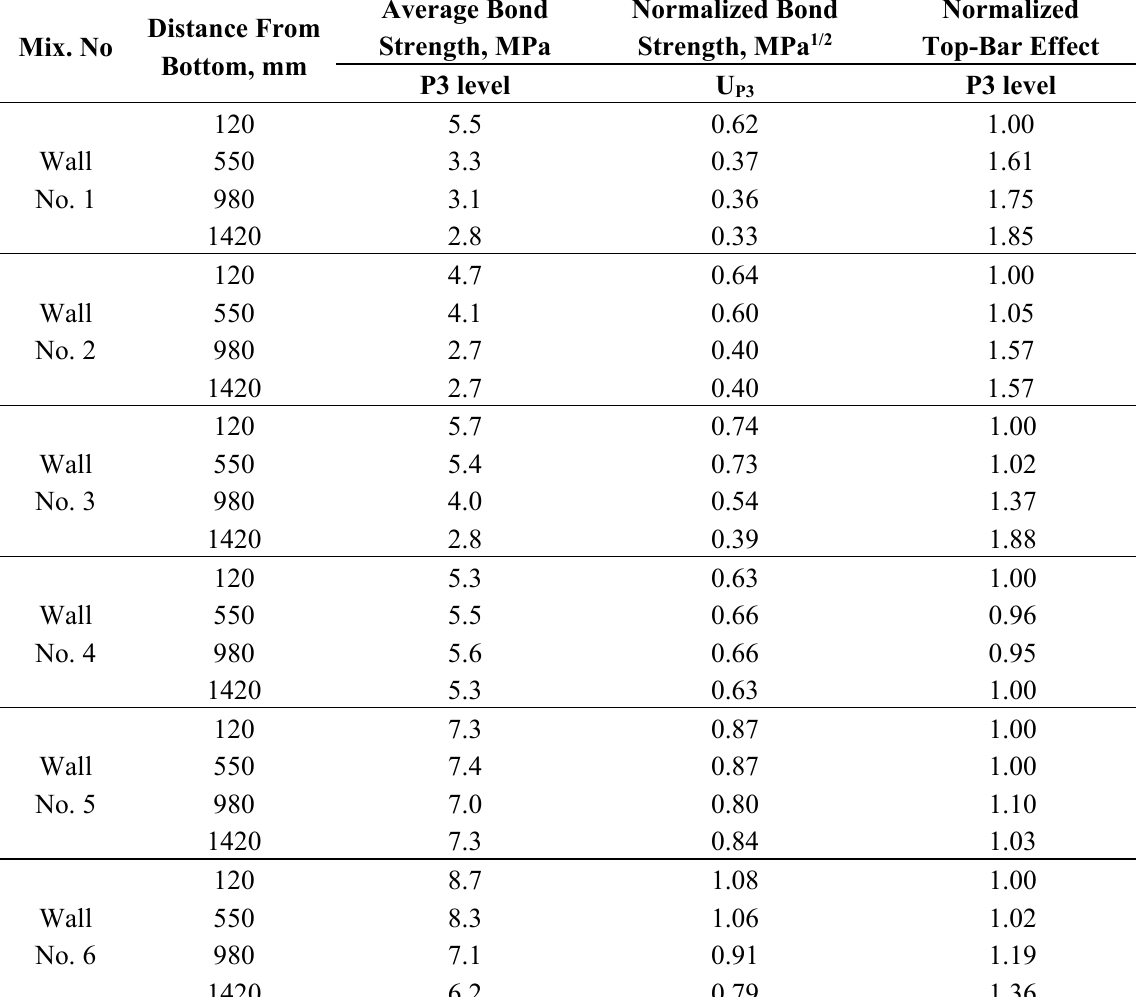
Table 4. Bond strength and top-bar effect of prestressing strands at 56 days of